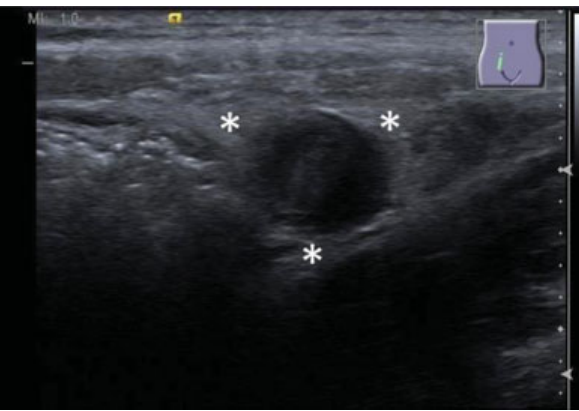
Fig. 3 The periappendiceal tissue is hyperechoic, representing edema